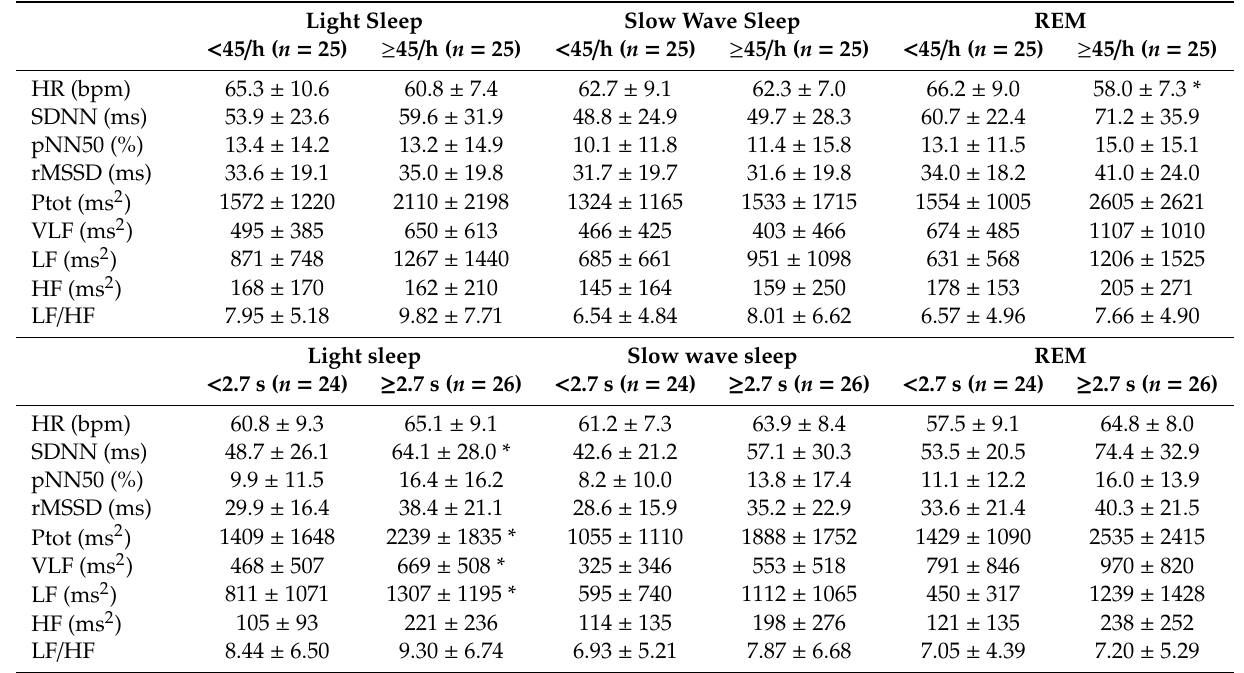
Table 4. Heart rate variability indices during periods with PLMS according to the PLM index and duration (mean ± SD). Light